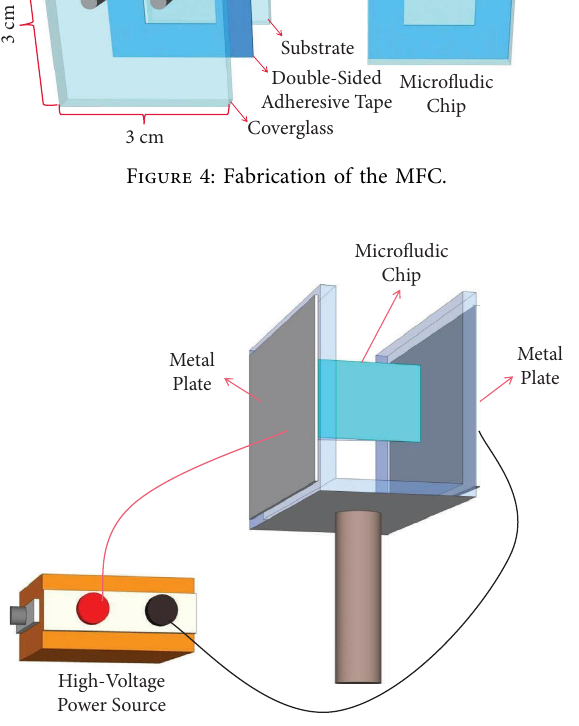
Figure 5: Diagram of an EF system.